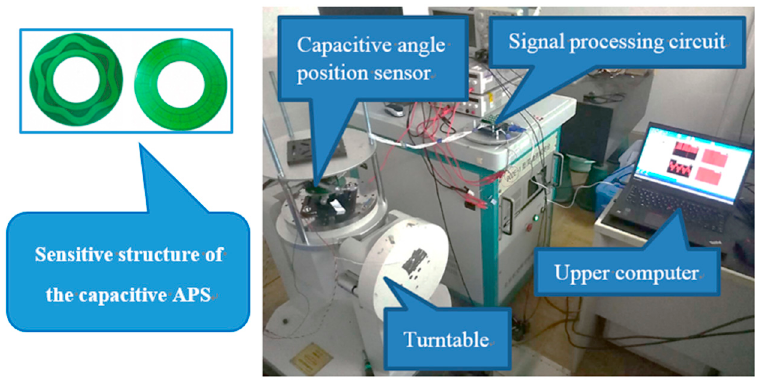
Figure 15. Experimental equipment, including a turntable, a CAPS, a signal processing circuit, and an upper computer.